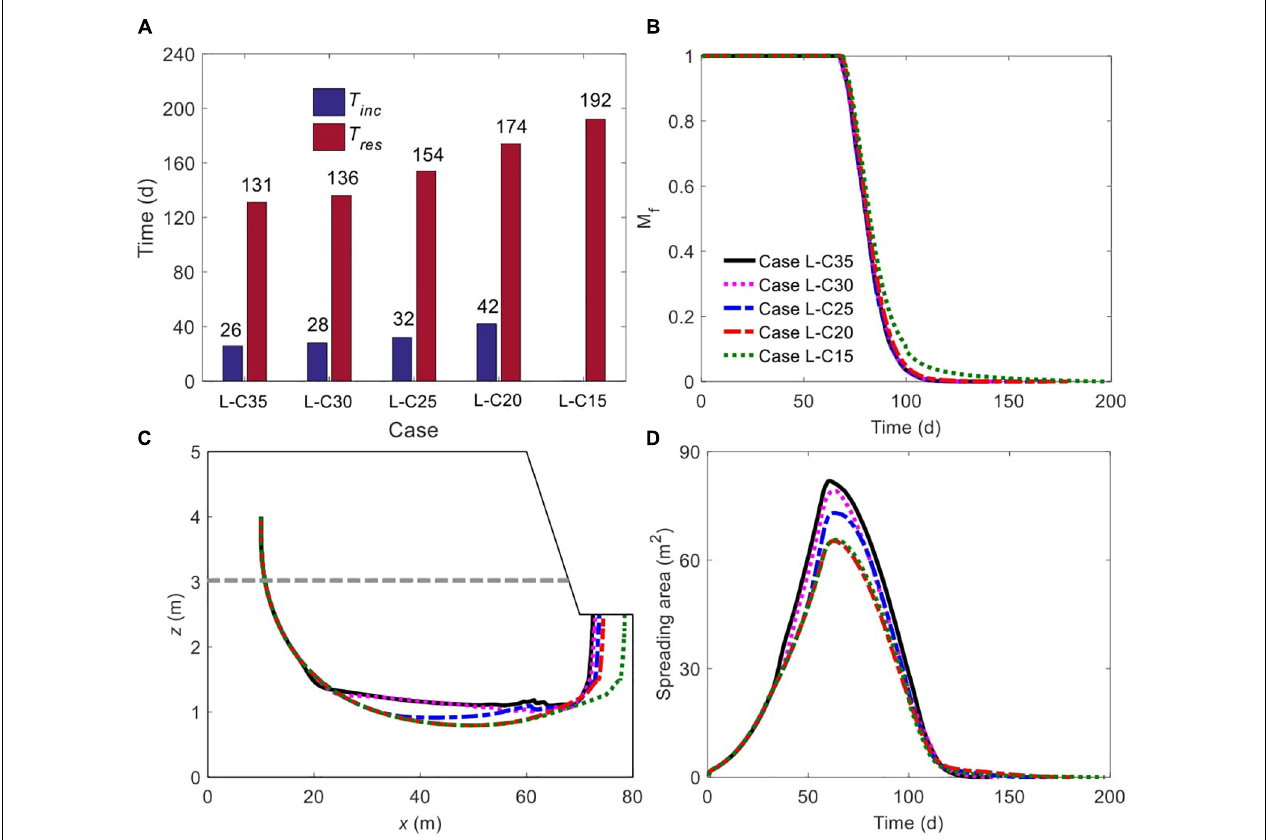
FIGURE 10 | Comparison of (A) initiation time of unstable flow and residence time of solute plume, (B) time-dependent, normalized amount of solute mass remaining in marsh soil, (C) spatiotemporal variation of plume centroid, and (D) plume spreading area for different ratios of C sea / C pore . The plume edge was determined based on the concentration of 0.0001 C 0 . The gray dashed line in panel (C) represents the boundary between mud layer (upper) and sand layer (deeper).